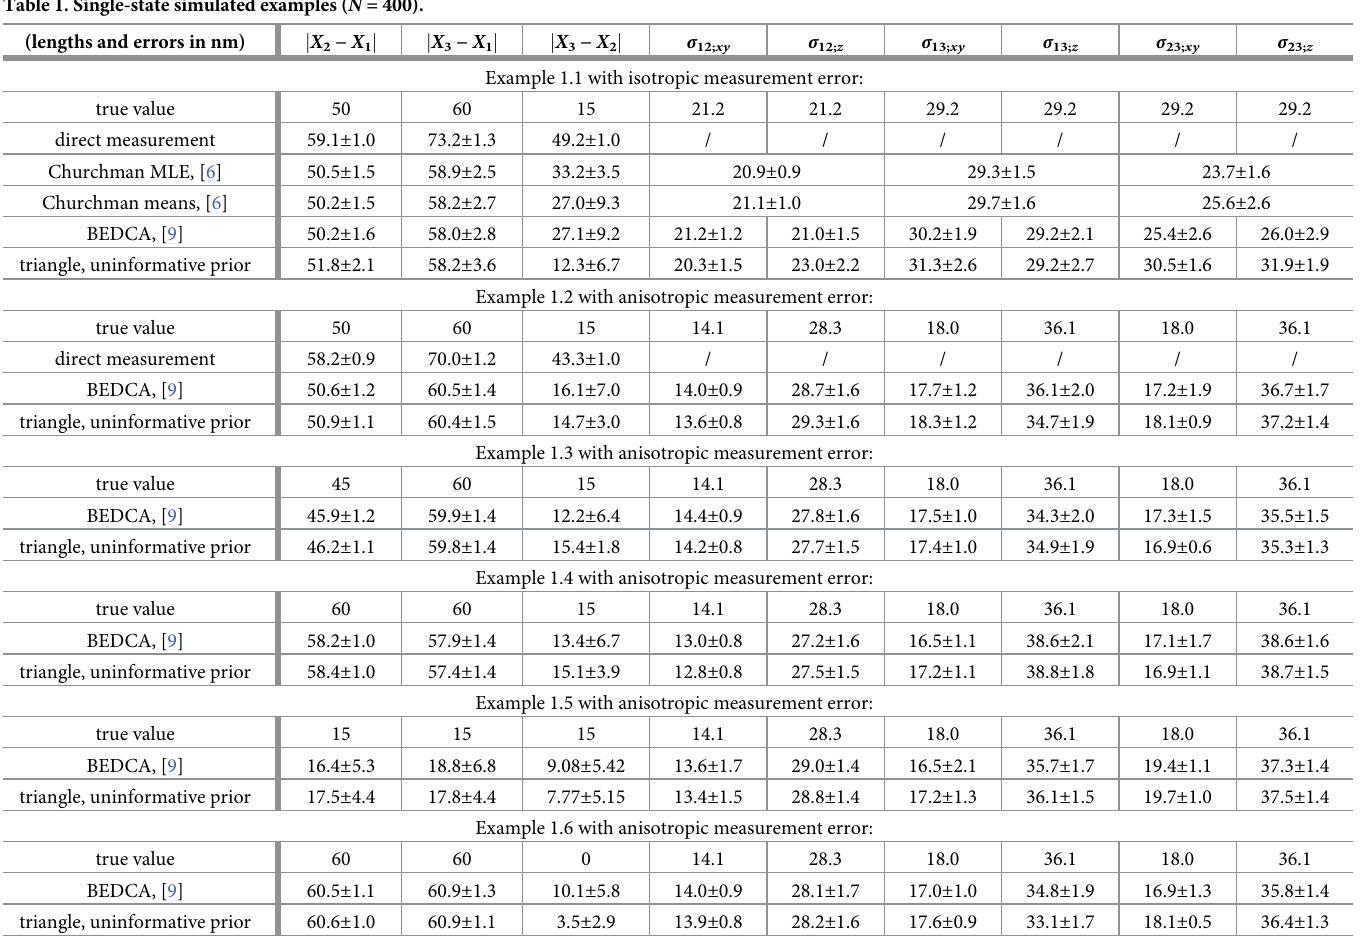
Table 1. Single-state simulated examples ( N =